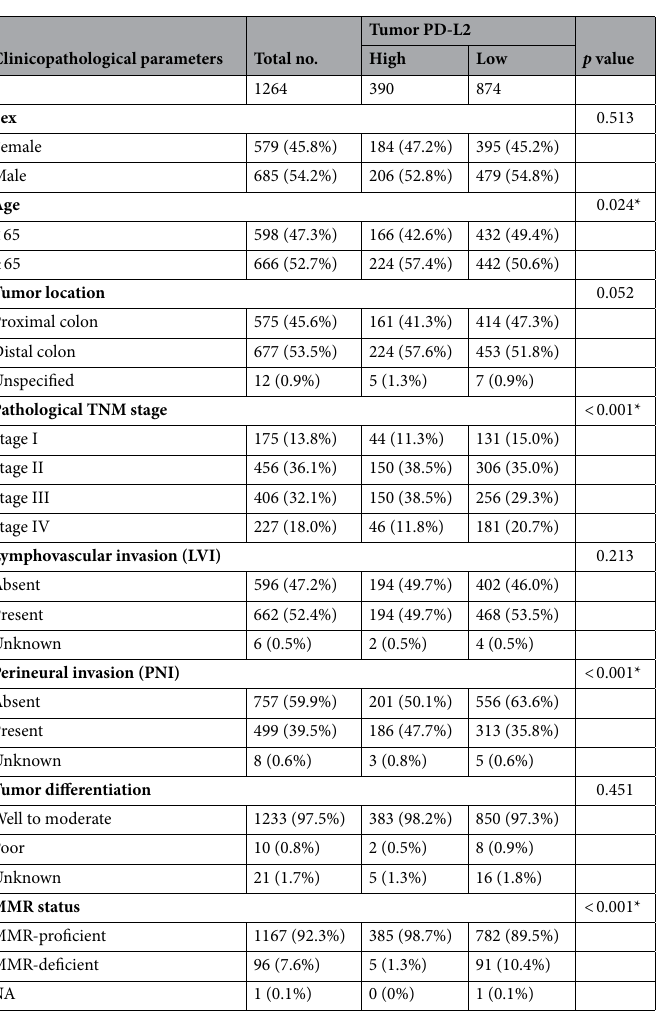
Table 1. Tumor characteristics in colon carcinoma patient (n = 1264). NA: not available. The Fisher’s exact test did not include the “NA” and "unknown" group. *indicated p